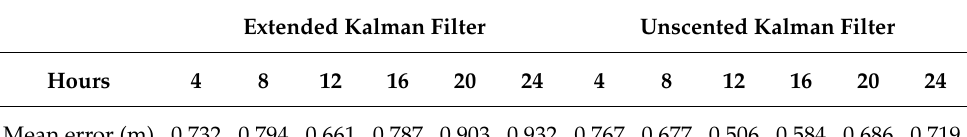
Table 4. Mean error for the DGPS receiver with base station position averaged after a set number of